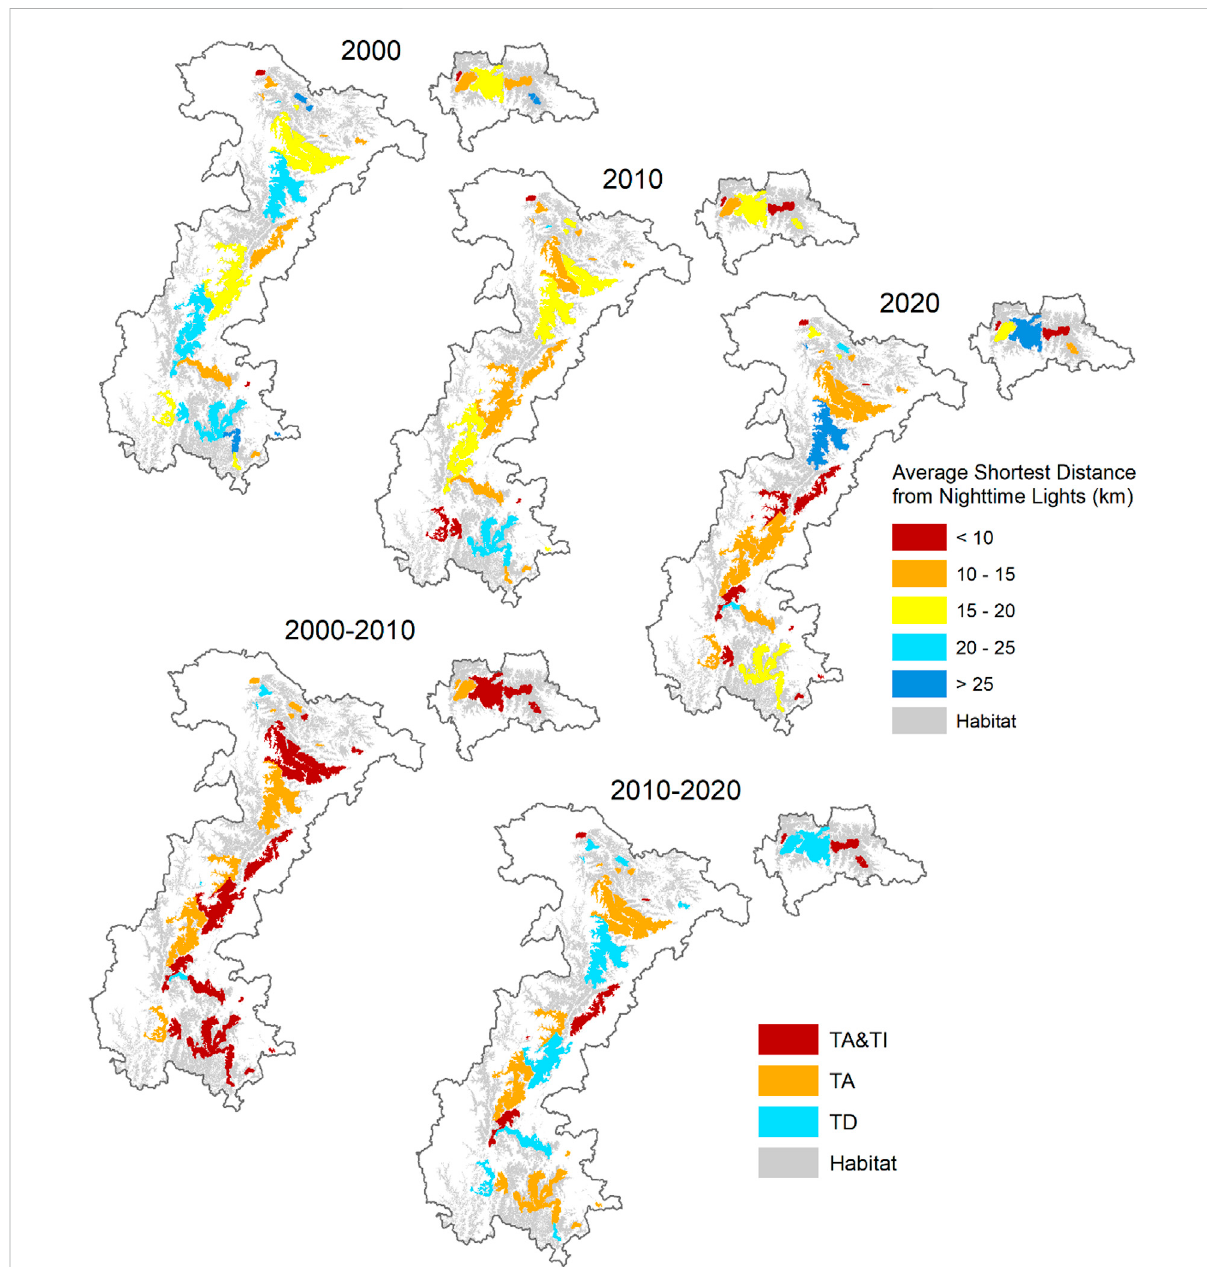
FIGURE 7 Spatial patterns and dynamics of giant panda population threatened status. (TA&TI, light sources are closer to the population and more intensi fi ed; TA, light sources are closer to the population; TD, light sources are further away from the